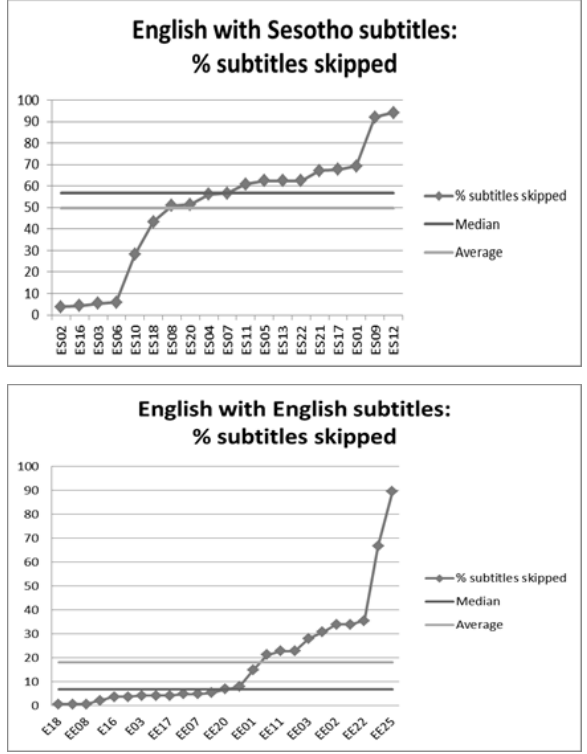
Figure 10. Percentage subtitles skipped for Groups ES and